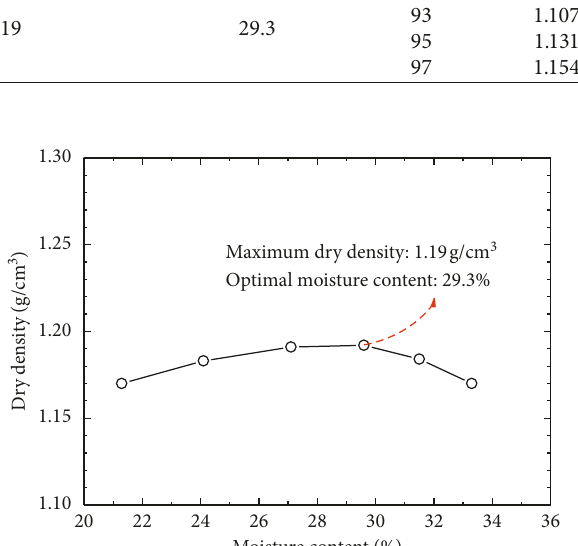
Figure 2: Results of heavy compaction test on fly